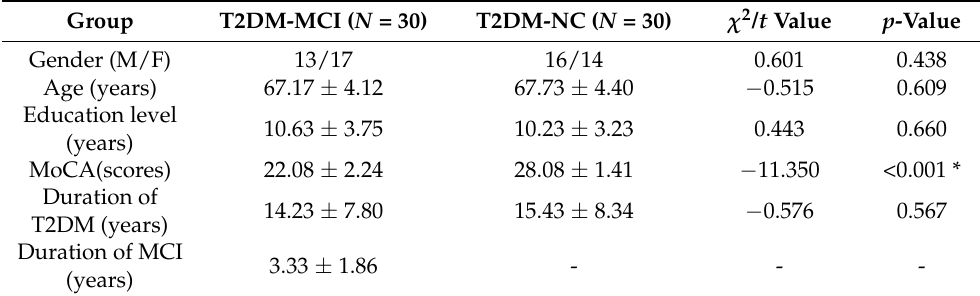
Table 1. Clinical characteristics of the participants.